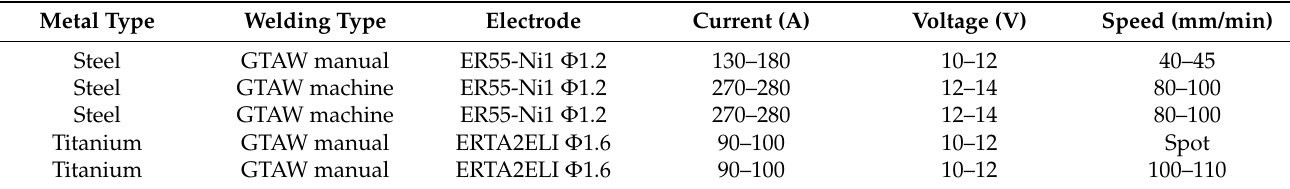
Table 6. Welding controlling